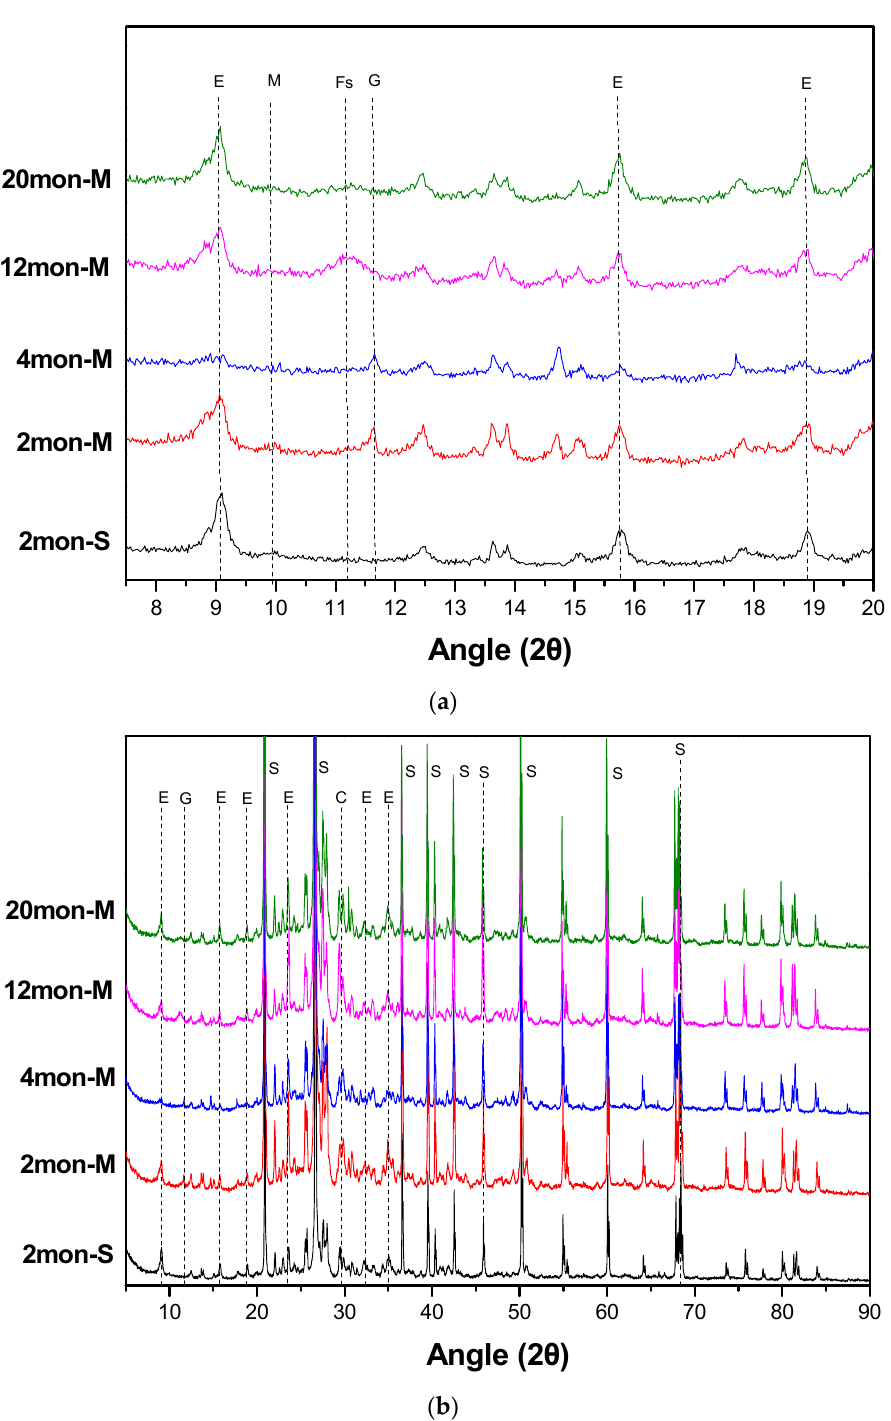
Figure 6. XRD pa tt erns of CSA concrete samples after 2, 4, 12, and 20 months of marine tidal expo- Figure 6. XRD patterns of CSA concrete samples after 2, 4, 12, and 20 months of marine tidal exposure. sure. ( a ) 2 θ = (5–20°), where (E)—E tt ringite; (M)—AFm; (Fs)—Fridel’s salt; (G)—Gypsum. ( b ) 2 θ = ( a ) 2 θ = (5–20 ◦ ), where (E)—Ettringite; (M)—AFm; (Fs)—Fridel’s salt; (G)—Gypsum. ( b ) 2 θ = (5–89 ◦ ), (5–89°), where (E)—E tt ringite; (G)—Gypsum; (C)—Calcite; (S)—SiO 2 ). where (E)—Ettringite; (G)—Gypsum; (C)—Calcite; (S)—SiO 2